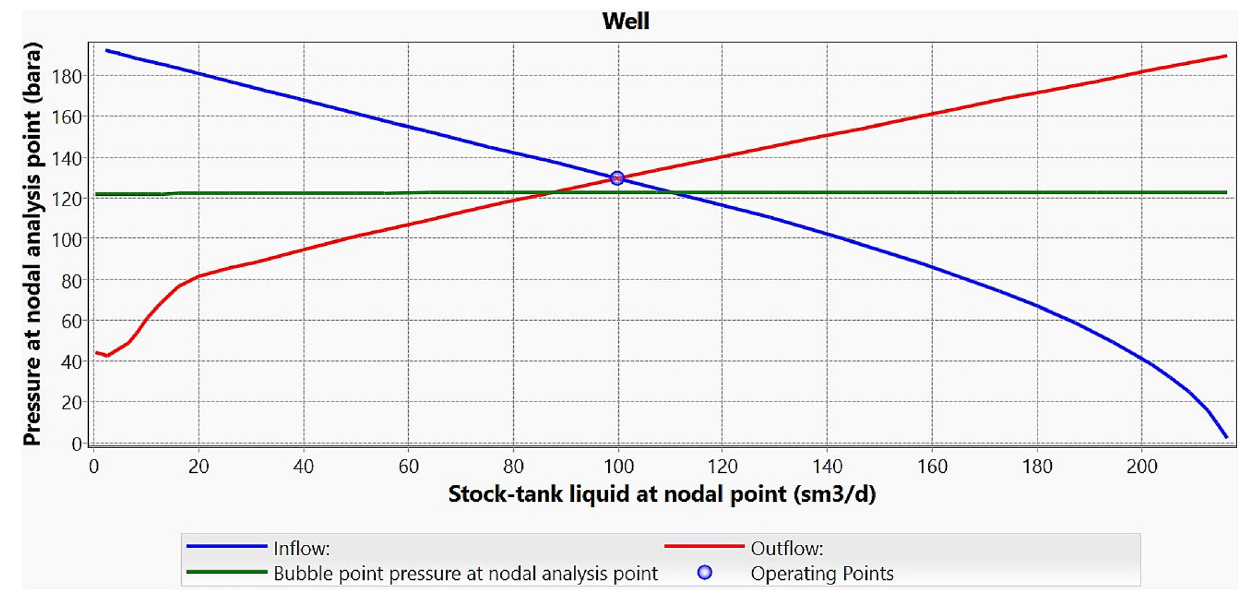
Fig. 2 Characteristics of the reservoir–well system of a gas-lift well